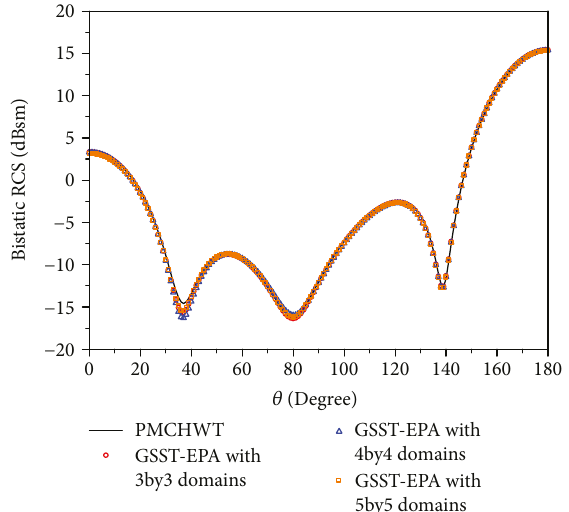
Figure 13: The convergence of GSST-EPA for the dielectric